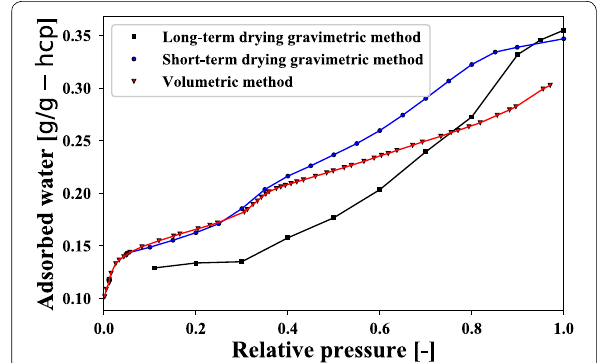
Fig. 4 Water vapor sorption isotherm measured by gravimetric method, i.e., slowly drying (i.e., long-term drying) and RH–TG (i.e., short-term drying) (data from Maruyama et al. (2014) and Maruyama and Rymeš (2019)) and volumetric method (data from Maruyama et al.